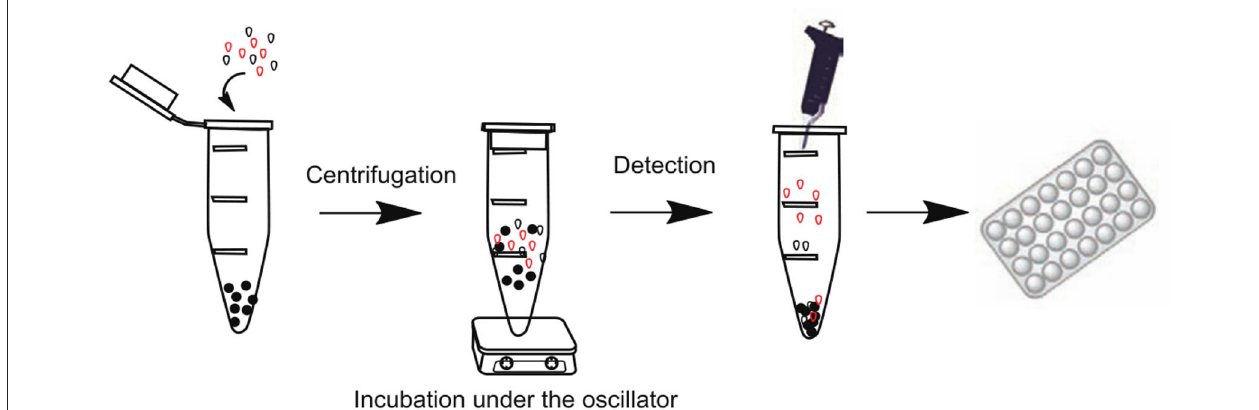
FIGURE 8 | Schematic diagram of DMIP-Trimel Fluorescence Competitive Analysis (Du et al., 2016). Reprinted with permission from Elsevier. Copyright (2016) Elsevier.